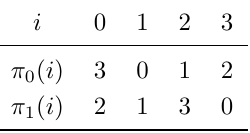
Table 3: The correspondence between the input and output bit indices in 𝜋 0 and 𝜋 1